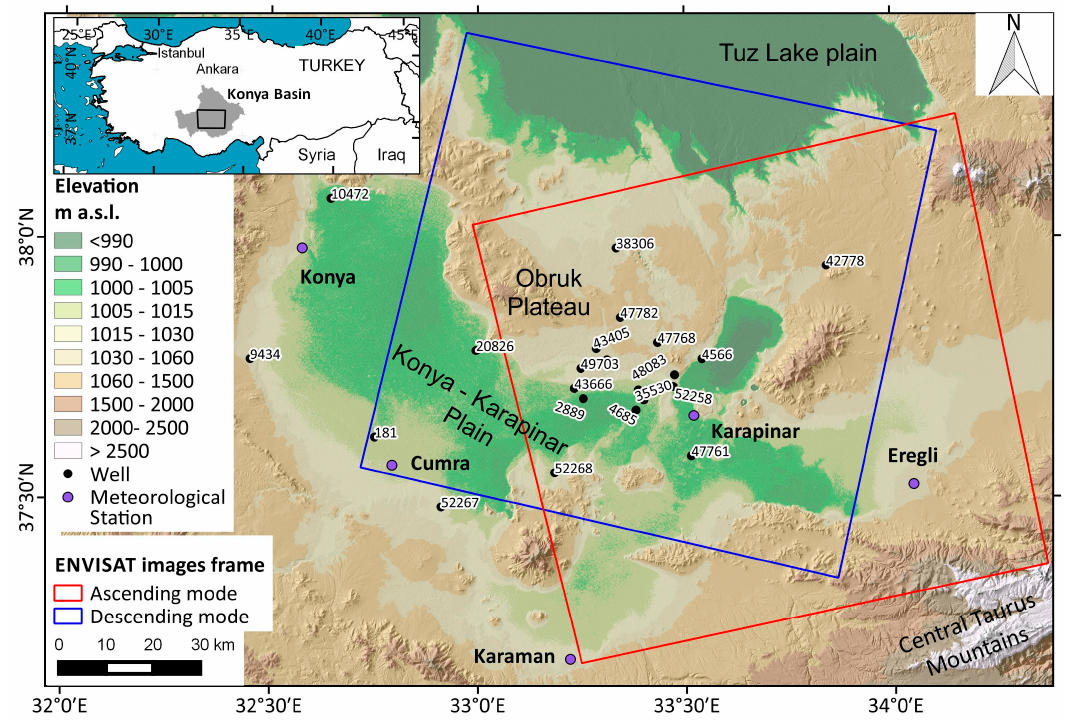
Figure 1. Study area: location and topography. Frames show the footprints of the ascending ( red ) and descending ( blue ) ENVISAT SAR data used in this study. Location of meteorological stations, groundwater and stratigraphic wells used in this study is also shown.